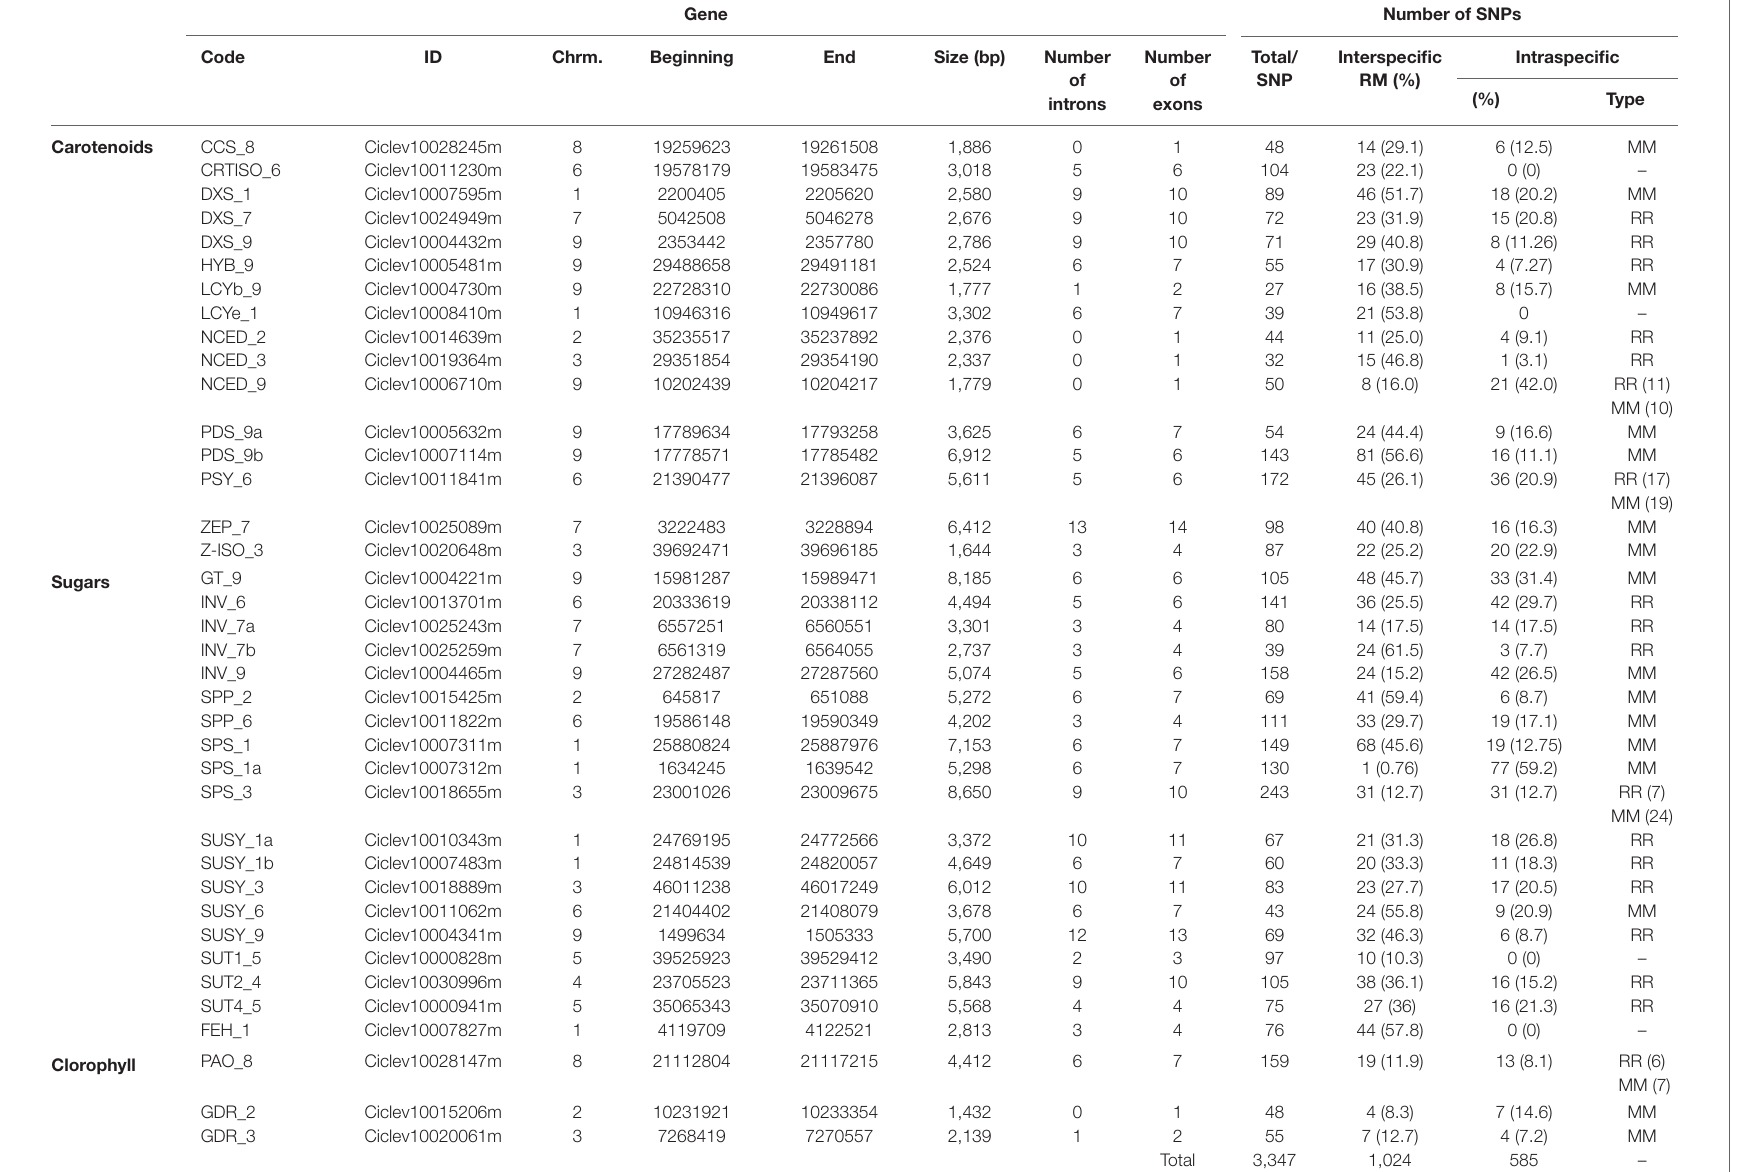
TABLE 1 | List and characteristics of the genes used in this study. Chrm.: chromosome. R: C. reticulata. M: C. maxima. Gene Number of SNPs Code ID Chrm. Beginning